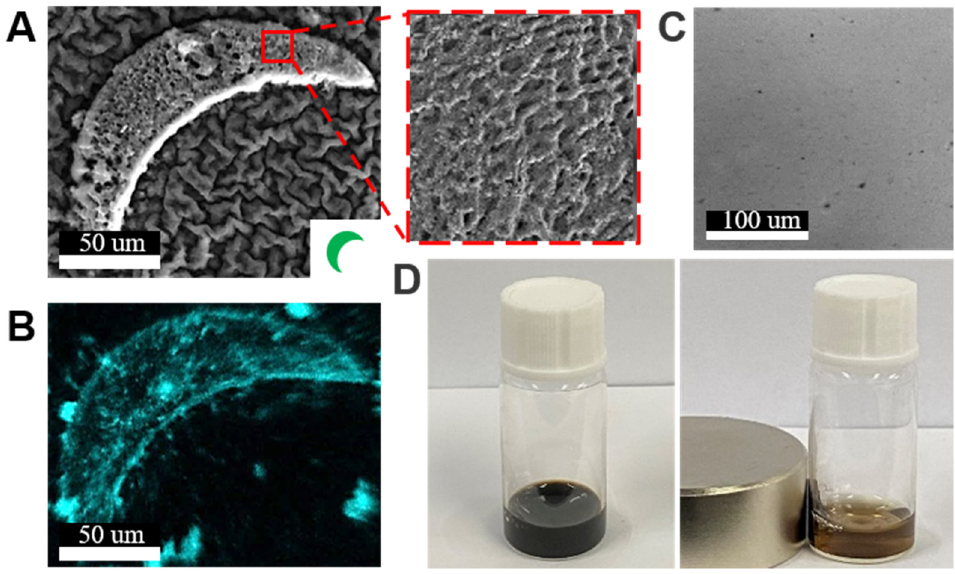
Figure 2. ( A ) SEM image of a hydrogel crescent microswimmer. The inset figure in the lower right corner is the pattern on the transparent mask used to make the microswimmers. The zoomed-in figure shows the porous structures of the microswimmer. ( B ) The EDS of the iron element indicated the presence of Fe 3 O 4 . ( C ) Optical image of Fe 3 O 4 nanoparticles uniformly dispersed in the hydrogel precursor suspension. ( D ) When the neodymium iron boron magnet was placed close to the hydrogel precursor suspension, the Fe 3 O 4 nanoparticles gathered to the position closest to the magnet.